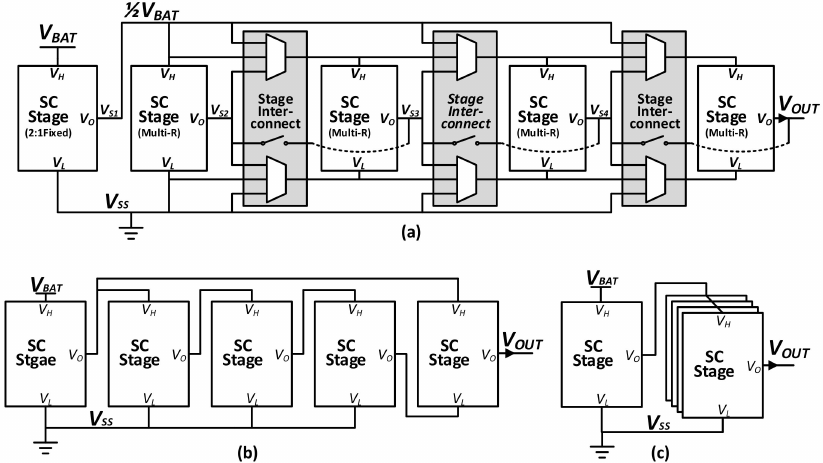
Figure 6. Multistage converter ( a ) Proposed reconfigurable SC topology. ( b ) Series connected. ( c ) Parallel connected.